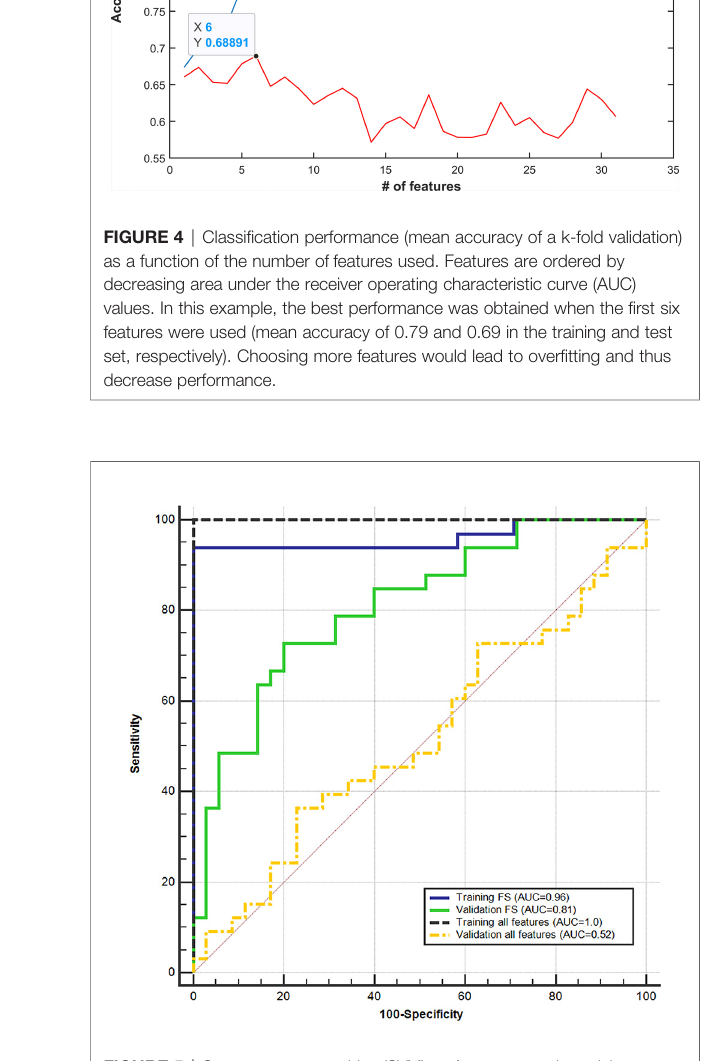
FIGURE 5 | Support vector machine (SVM) performance on the training set and validation set in discriminating between low (GG ≤ 2) and high (GG > 2) aggressive prostate cancers. receiver operating characteristic (ROC) curves were obtained using all parameters and after applying the feature selection